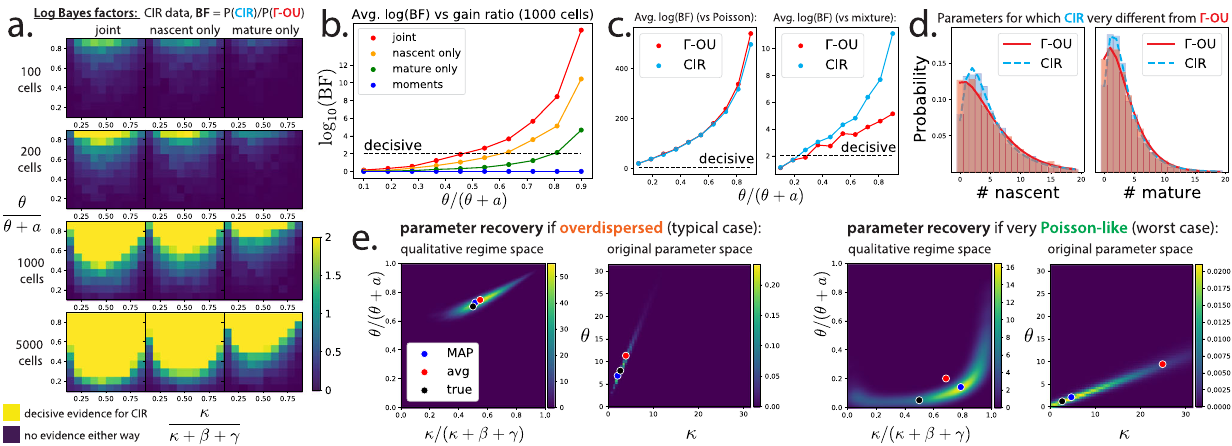
Fig. 3 | Model distinguishability and parameter inference. a Log Bayes factors show models are distinguishable in most of parameter space. Plotted are the average log Bayes factors capped at 2 (a common threshold for decisive evidence in favor of one model). b Models are often strongly distinguishable. A slice of the 1000cellrowofthepreviousplot(withoutthe cap at2)foramoderatevalueof κ / ( κ + β + γ ). Using both nascent and mature data is better than using either indivi- dually,usuallybyatleastanorderofmagnitude. c Itiseasytodistinguishthe Γ -OU and CIR models from trivial models. Same axes as in ( b ). Discriminability of Γ -OU andCIRmodelsversusPoissonandmixturemodelsforasomewhatsmallvalueof κ ( κ /( κ + β + γ )=0.1),wherediscriminabilityisexpectedtobedif fi cult. d Nascentand